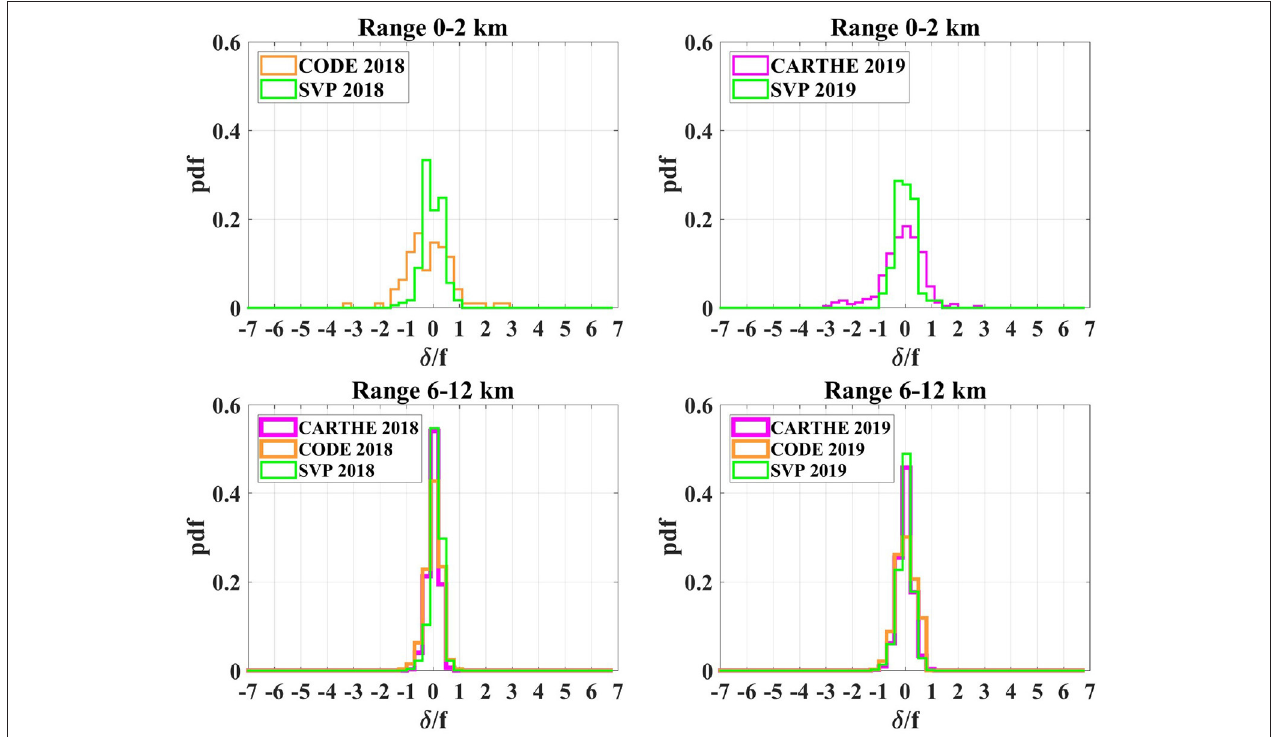
FIGURE 6 | Distribution of normalized divergence estimates for the 3 types of drifter (magenta for CARTHE, orange for CODE, and green for SVP) during the experiments 2018 (left) and 2019 (right) calculated from drifter triplets in the ranges: < 2 km (upper) and (6–12) km (lower)